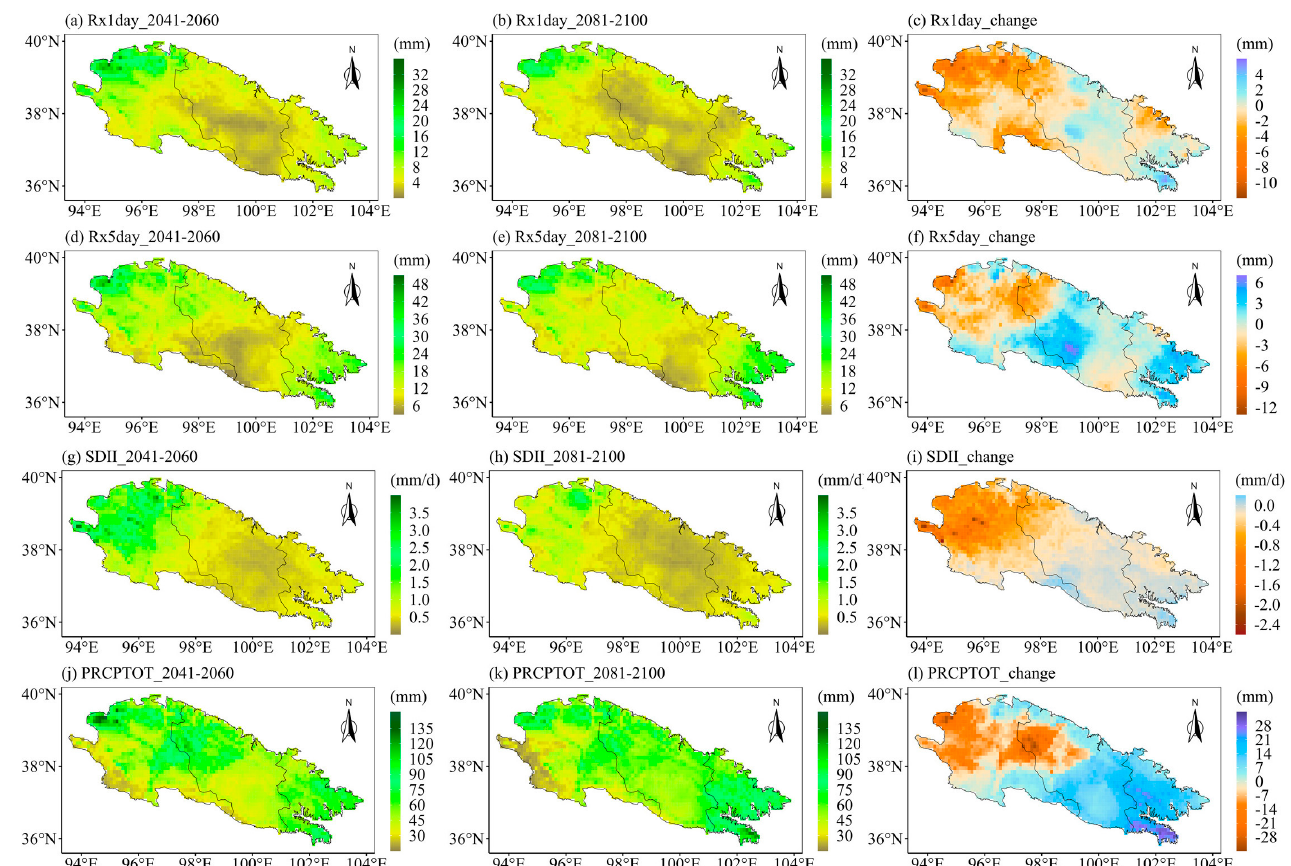
Figure 11. ( left ) The changes of extreme precipitation indices in the middle of the 21st century as compared to the base period, ( middle ) the changes of extreme precipitation indices at the end of the 21st century as compared to the base period, and ( right ) the changes of extreme precipitation indices at the end of the 21st century as compared to the middle of the 21st century. Spatial distribution over the Qilian Mountains under SSP126: ( a – c ) Rx1day, ( d – f ) Rx5day, ( g – i ) SDII, and ( j – l ) PRCPTOT. Note that the future change is represented by the ensemble of the corrected CMIP6 models.